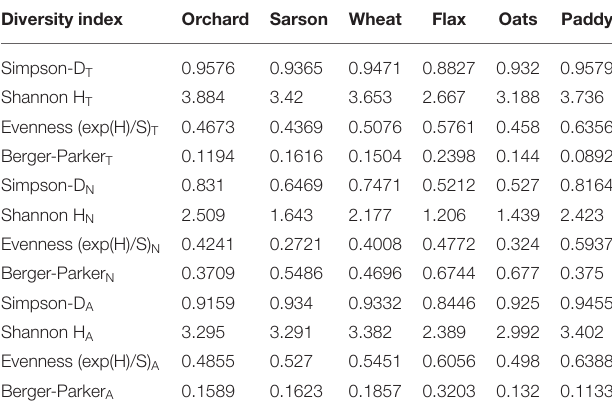
FIGURE 3 | Cluster dendrogram based on Jaccard’s dissimilarity index. TABLE 7 | Total, native and alien species diversity in surveyed